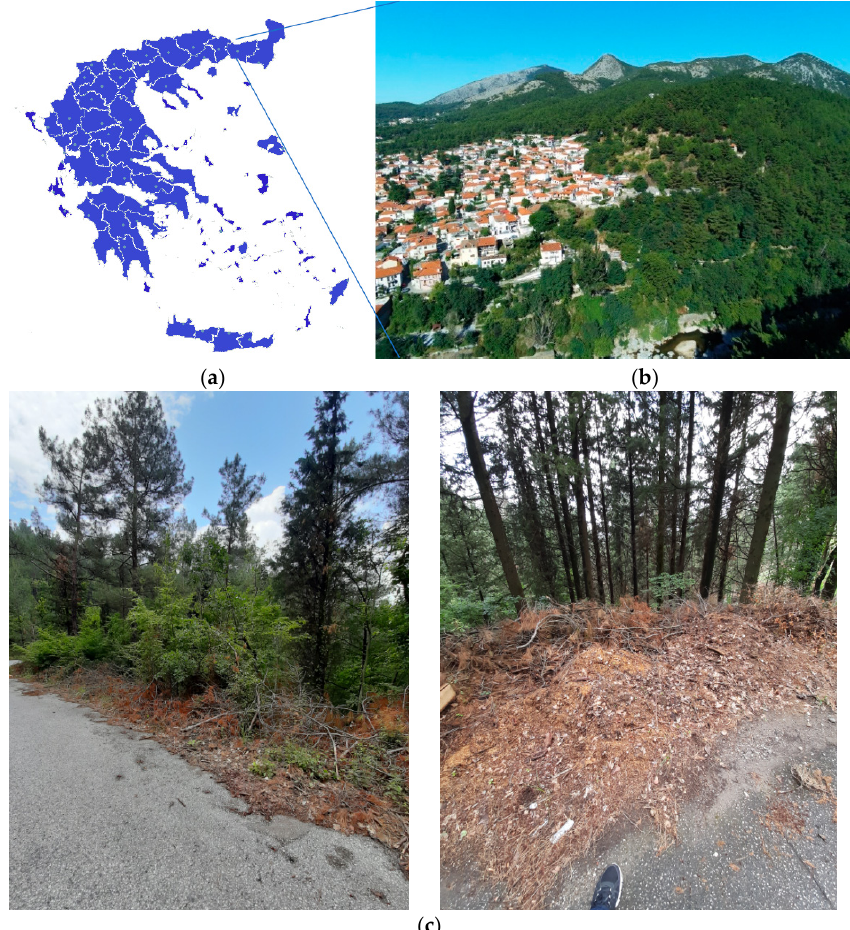
Figure 1. ( a ) Map of Greece showing the location of the study site, ( b ) aerial overview of the Pinus forest, and ( c ) current practices of forest residual biomass disposal on forest roads.